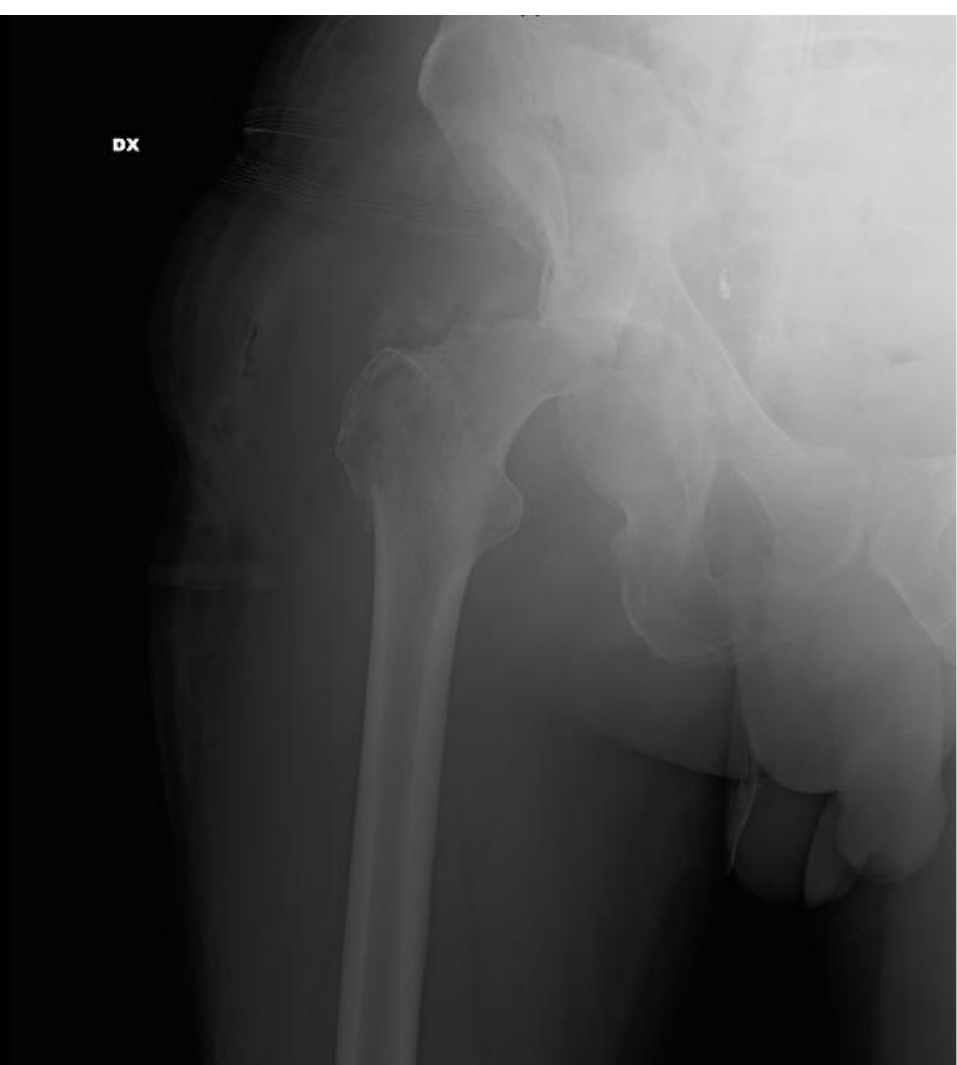
Figure 2. X-ray of the pelvis after the implant removal.